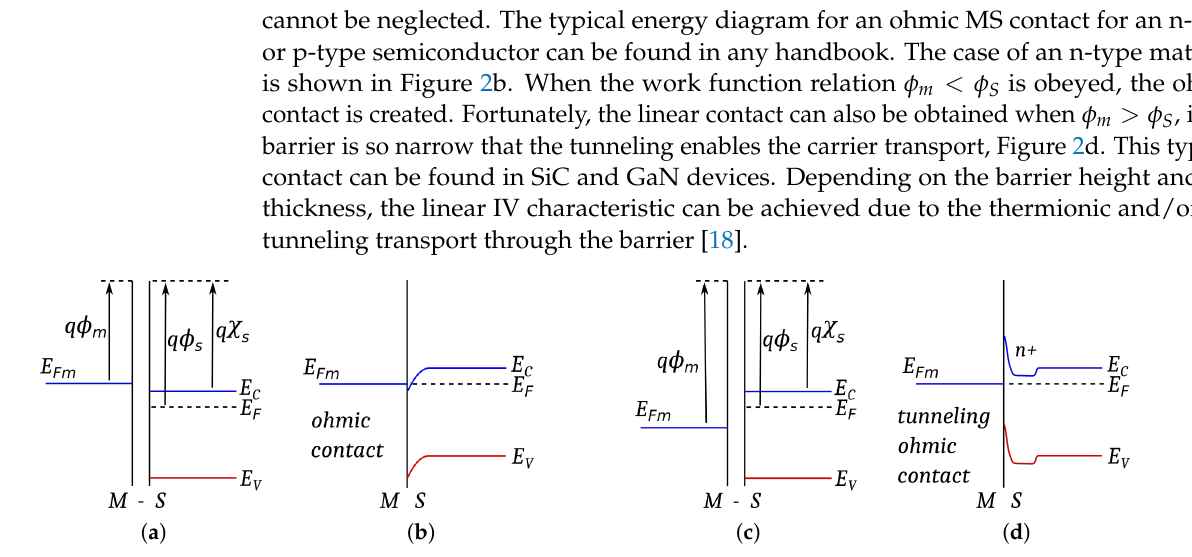
Figure 2. ( a ) Energy band diagram before contact for φ m < φ S . ( b ) Classic ohmic contact. ( c ) Energy band diagram before contact for φ m > φ S . ( d ) Tunneling ohmic contact.